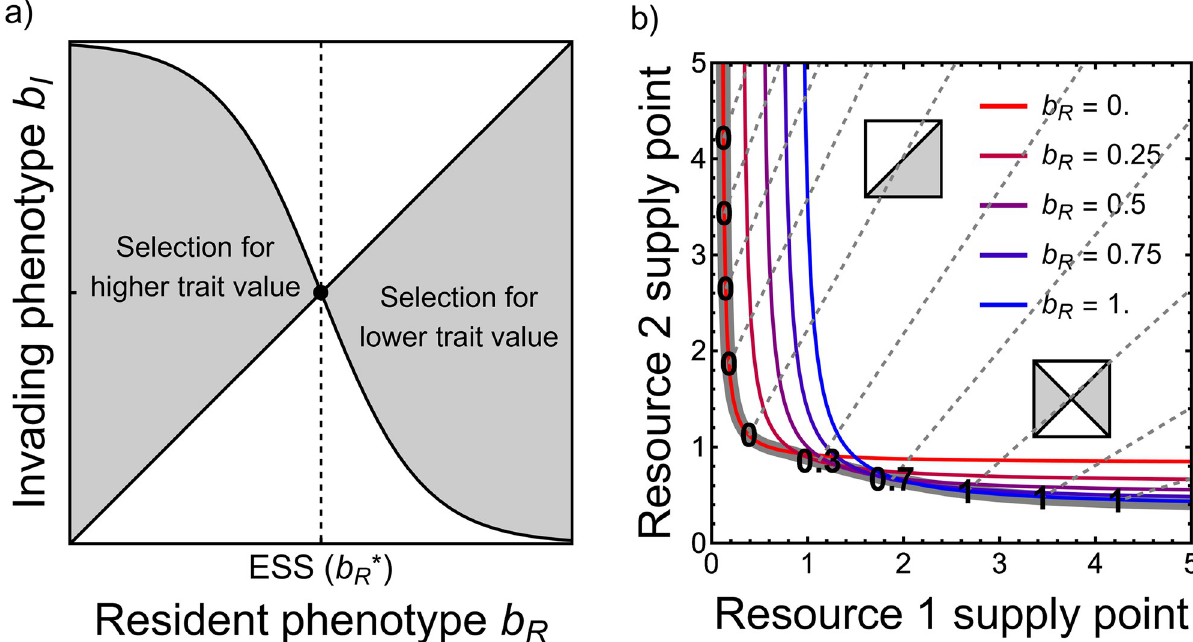
Fig 5. Overview of adaptive dynamics (see Box 2 for details). (a) Example pairwise invasibility plot (PIP). Shaded regions indicate pairs of resident (x- axis) and mutant (y-axis) trait values that result in a positive invasion growth rate for the mutant and thus predict a successful invasion; white regions indicate a negative invasion growth rate and loss of the mutation. An ESS is any resident trait value at which a vertical line passes through only white regions. (b) ZNGIs for different resident trait values (colors) as a function of the resource environment. The thick gray line marks the geometrical envelope, defined by the ESS strategy at any supply point (i.e., following the outermost ZNGI). Numbers on the envelope list select ESS values along this envelope and the dashed lines are their impact vectors (see Box 1).